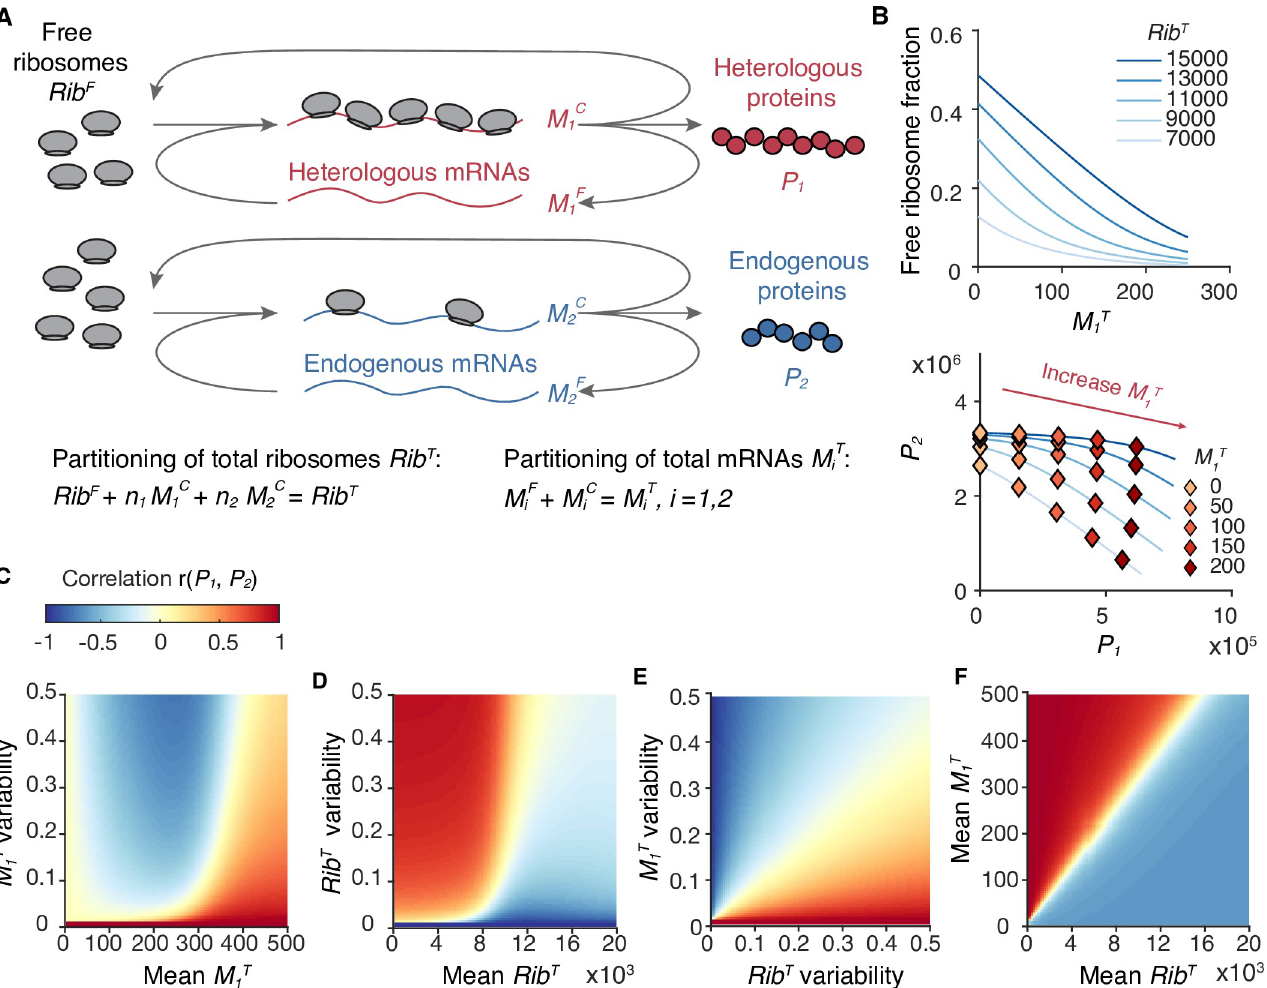
Fig 2. Coarse-grained model of translational resource competition. (A) The coarse-grained model considers ribosome allocation between heterologous ( i = 1) and endogenous ( i = 2) mRNAs. The input, the output, and the resource are total mRNA M iT , protein P i , and total ribosome Rib T , respectively. Rib T can either be free ribosome Rib F or mRNA-bound ribosome. (B) Ribosome competition in a single cell. Top, decrement of the free ribosome fraction ( Rib F / Rib T ) caused by increasing M 1T . Bottom, negative correlation between endogenous protein ( P 2 ) and heterologous proteins ( P 1 ). Calculations of Rib F , P 1 , and P 2 are described in Note 1.2 in S1 Text, with parameters listed in Table A in S1 Text. (C-F) Correlation between P described in Note 1.3 in S1 Text. M 2T variability is set as zero for simplicity. (C) Mean Rib T (10,000) and Rib T variability (0.1) are set as constants. (D) Mean M 1T (300) and M 1T variability (0.1) are set as constants. (E) Mean M 1T (300) and mean Rib T (10,000) are set as constants. (F) M 1T variability and Rib T variability (both 0.1) are set as